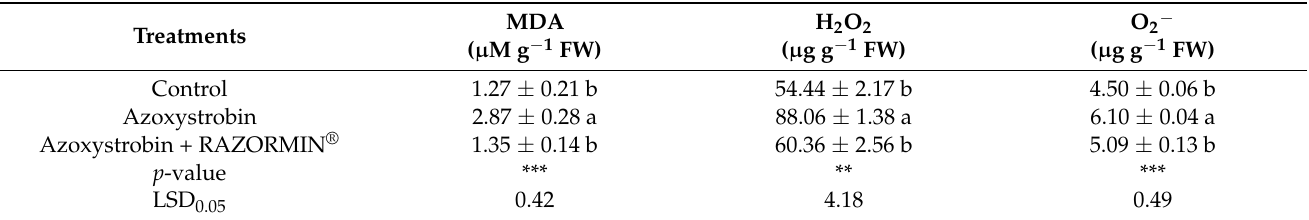
Table 10. Effect of the application of biostimulant RAZORMIN ® on some oxidative stress indicators in pepper plants subjected to the fungicide